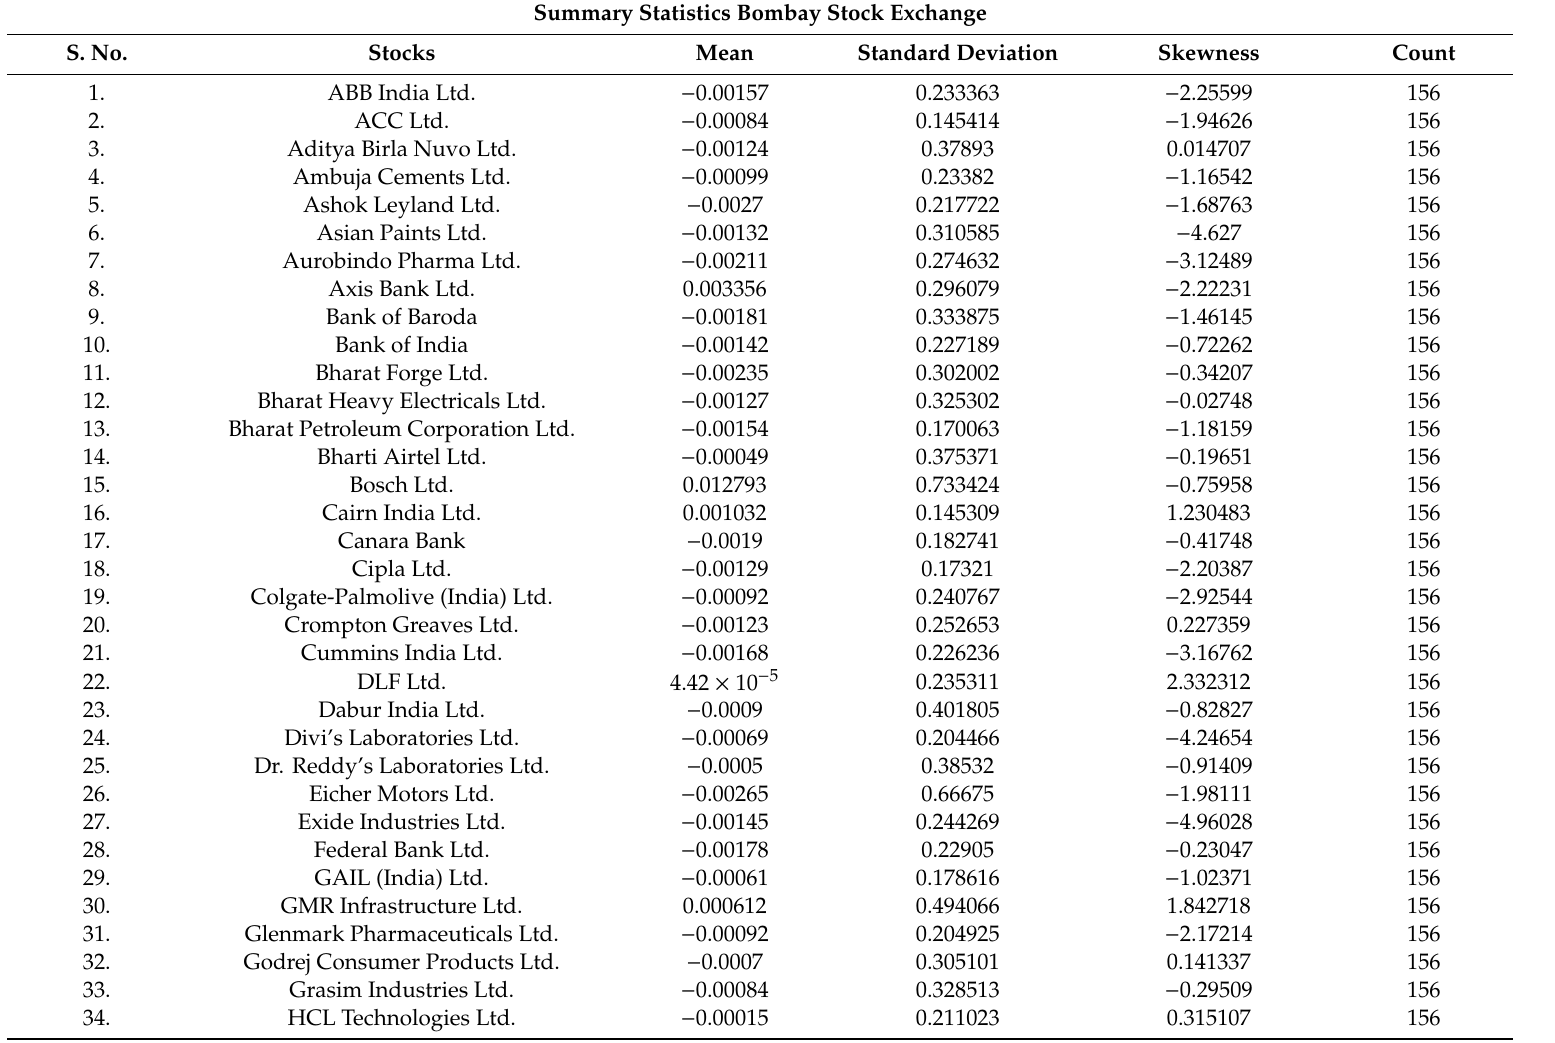
Table A3. Summary Statistics of Bombay Stock Exchange. Summary Statistics Bombay Stock